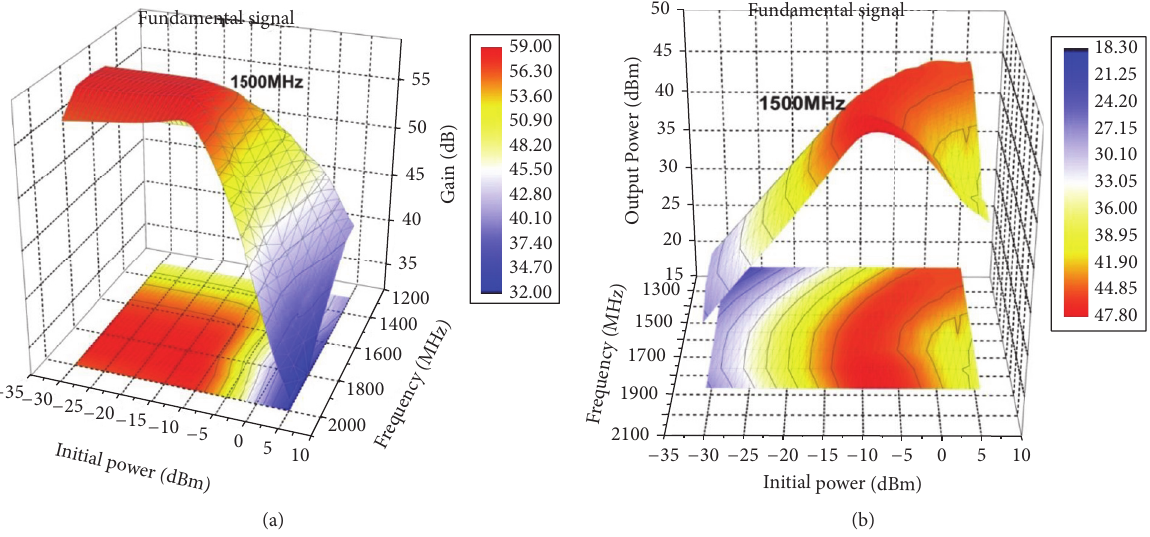
Figure 1: (a) 3D plot of output gain; (b) 3D plot of output power according to the fundamental frequency and initial power.